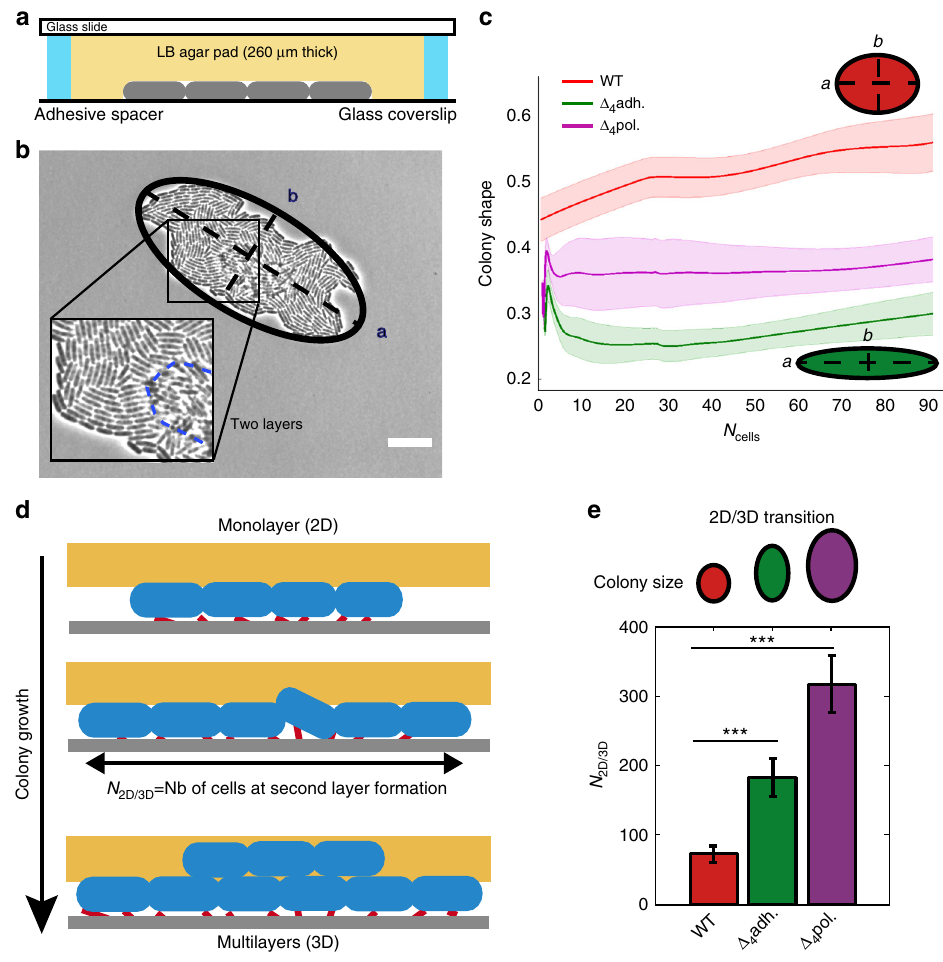
Fig. 1 In fl uence of bacterial adhesion on microcolony morphogenesis. a Schematic of the culture chamber. Bacteria are con fi ned between an agarose pad and a glass coverslip. b Image of a wild type E. coli microcolony after the formation of a second layer. The microcolony is fi tted with an ellipse with long axis a and short axis b . Scale bar represents 20 μ m. c Colony shape measured by the aspect ratio ( b / a ) for WT E. coli and mutants impaired in adhesive molecules as a function of the number of bacteria in the microcolony. d When microcolonies exceed a certain size ( N 2D/3D ), a second layer forms on top of the initial one. e Microcolony size at the onset of second layer formation. In c and d , error bars are de fi ned as s.e.m. (WT E. coli , red, N = 7; Δ 4 pol purple, N = 5; Δ = 5). Statistical analysis was performed using the unpaired t -test (*** p -value < 4 adh green, N